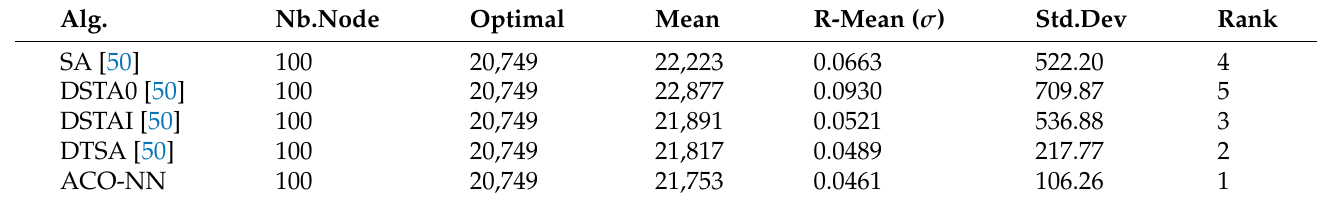
Table 8. Comparison of ACO-NN to various approaches for KroC100.